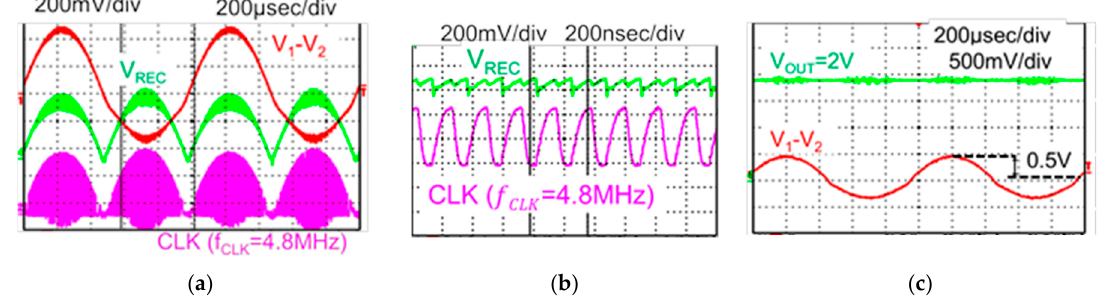
Figure 10. Die photo of the proposed system.